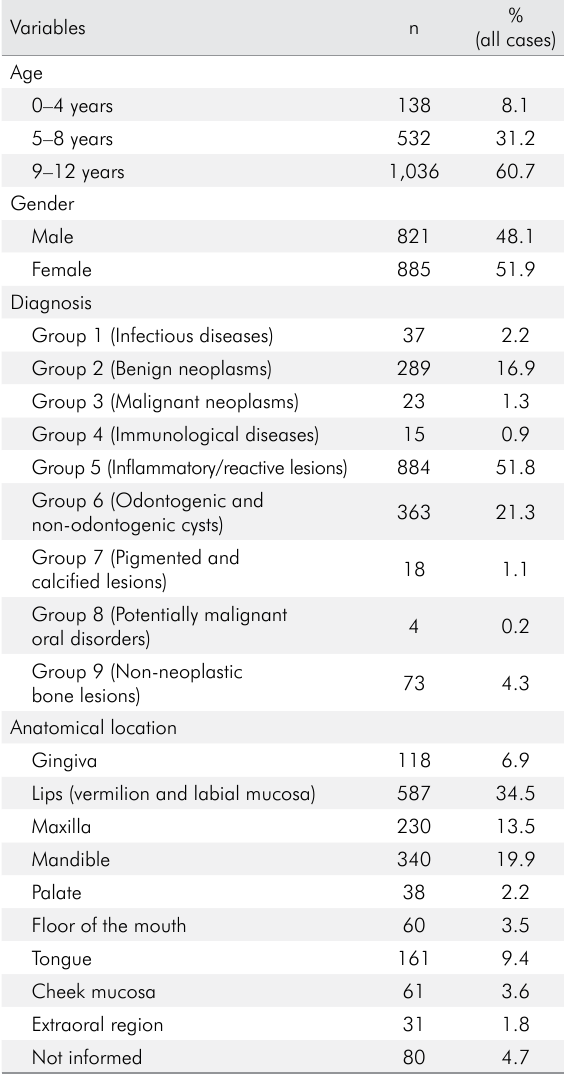
Table 1. Distribution of age, gender, diagnosis, and anatomical location of oral lesions in the pediatric patients